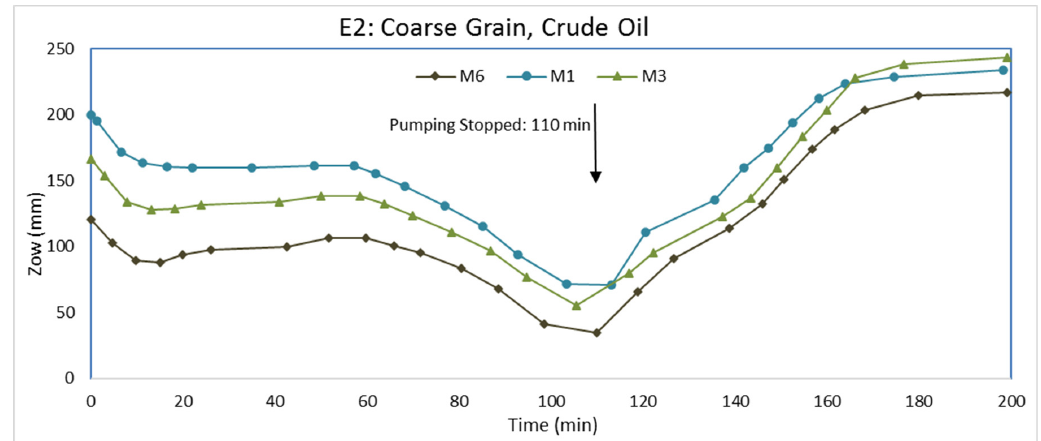
Figure 9. LNAPL-water interface elevation (Zow) variations in E2.